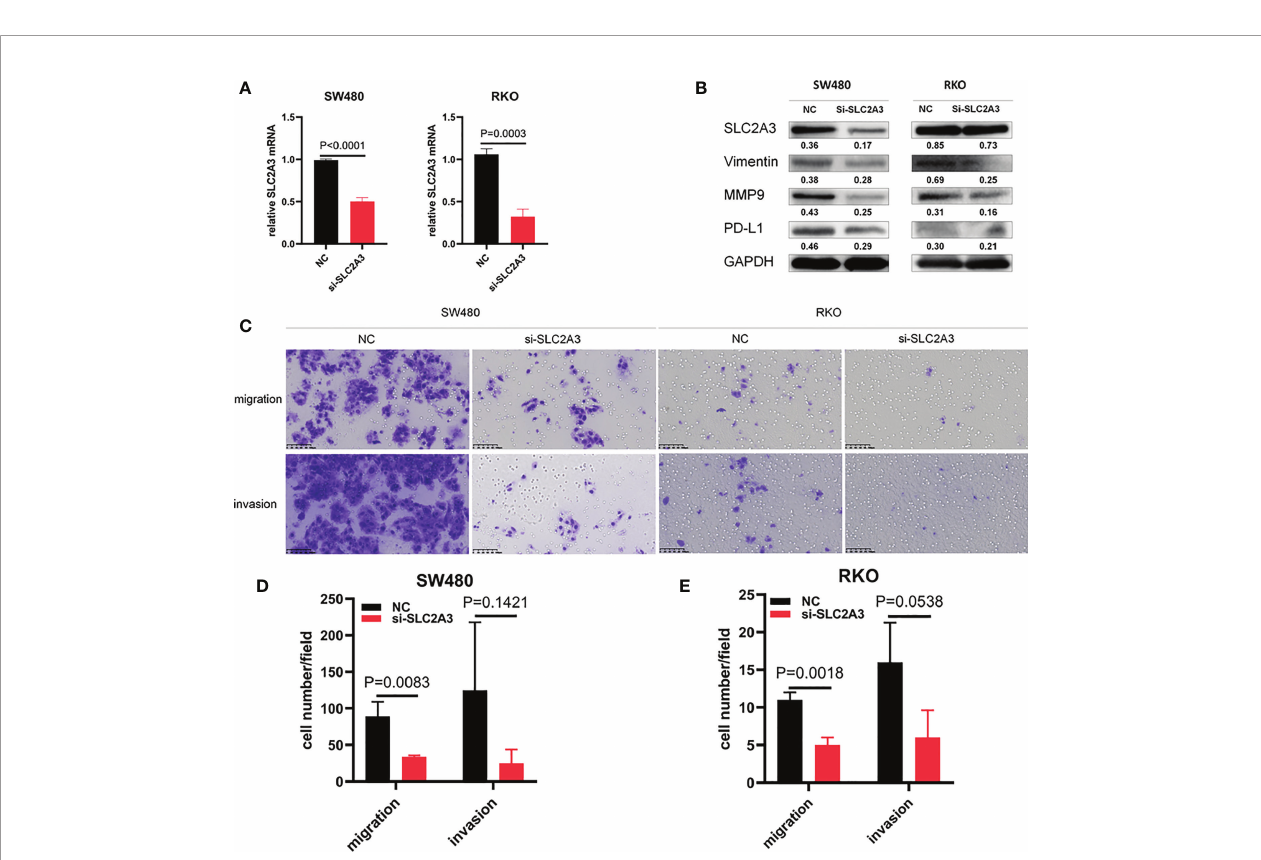
FIGURE 9 | SLC2A3 knockdown inhibited migration in CRC cell lines. (A) SLC2A3 mRNA expression decreased in SW480 and RKO transfected with SLC2A3 siRNA, respectively; (B) SLC2A3 knockdown inhibited Vimentin, MMP9, and PD-L1 expression in SW480 and RKO by Western blot, respectively; (C – E) SLC2A3 knockdown suppressed migration in SW480 and RKO cells, respectively (original magni fi cation, 200×).